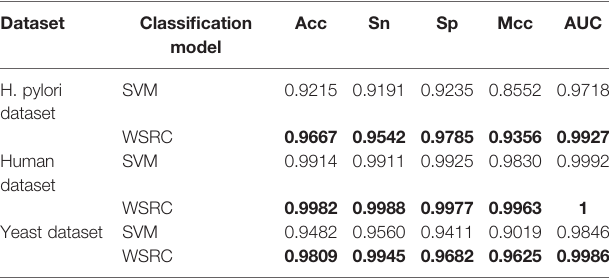
TABLE 3 | The prediction performance comparison of FCTP-WSRC with FCTP- SVM. Dataset